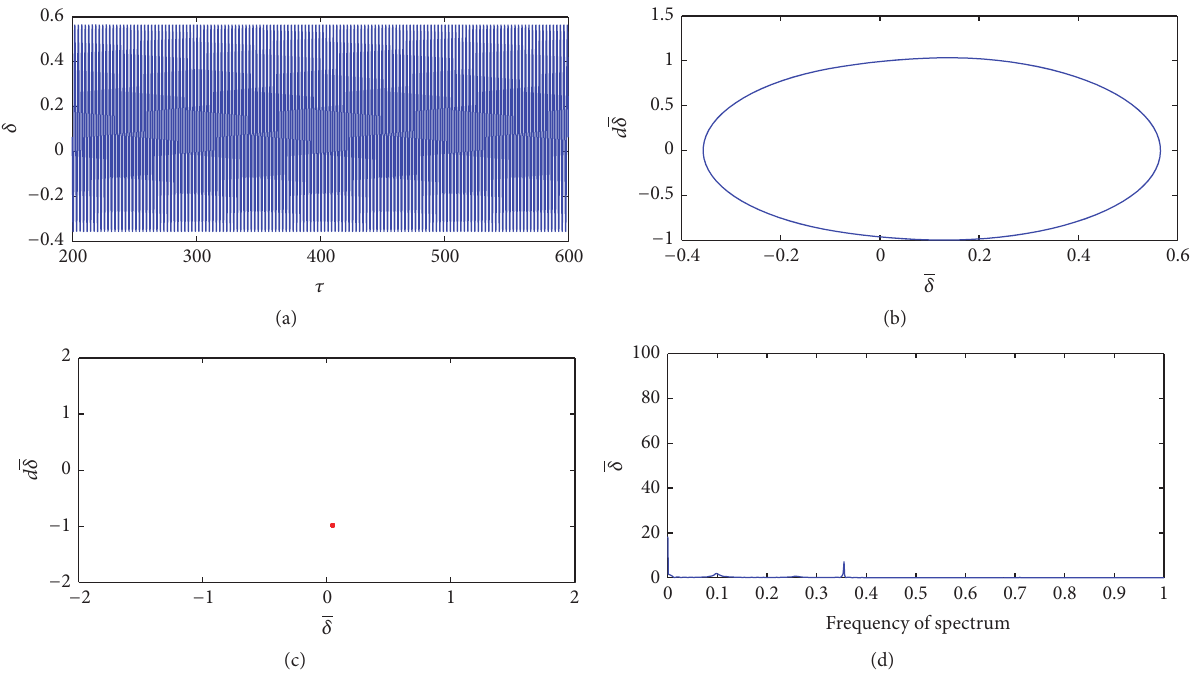
Figure 12: 𝑏 = 10 𝜇 m: (a) time history; (b) phase plane; (c) Poincar´e map; (d) Fourier spectrum.